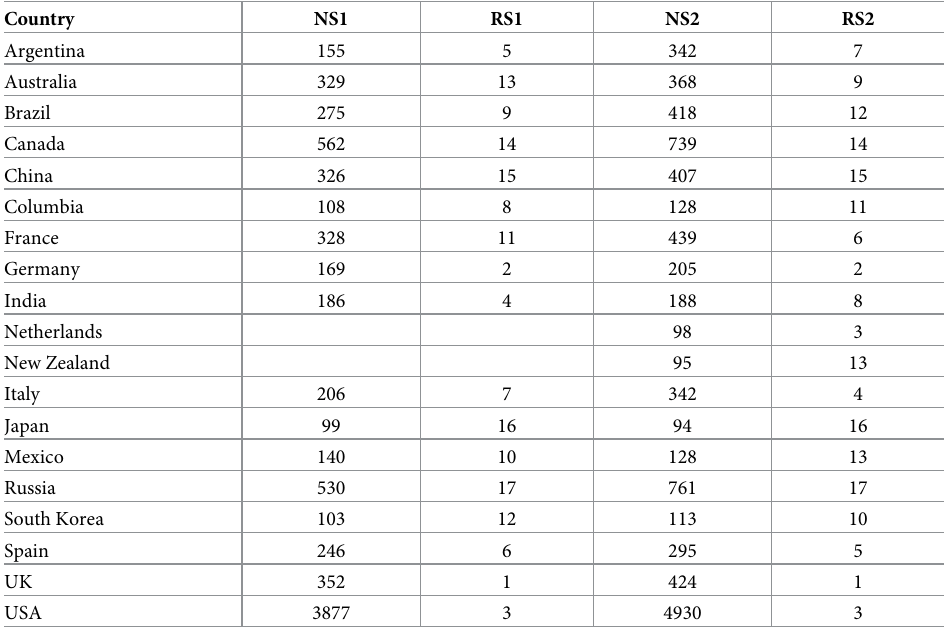
The number of respondents for survey 1 (NS1) and the number of respondents for Survey 2 (NS2) are given. The relative rank of a country for correct answers for Survey 1 (RS1) and Survey 2 (RS2) are also given. See text for how countries were ranked according to correct